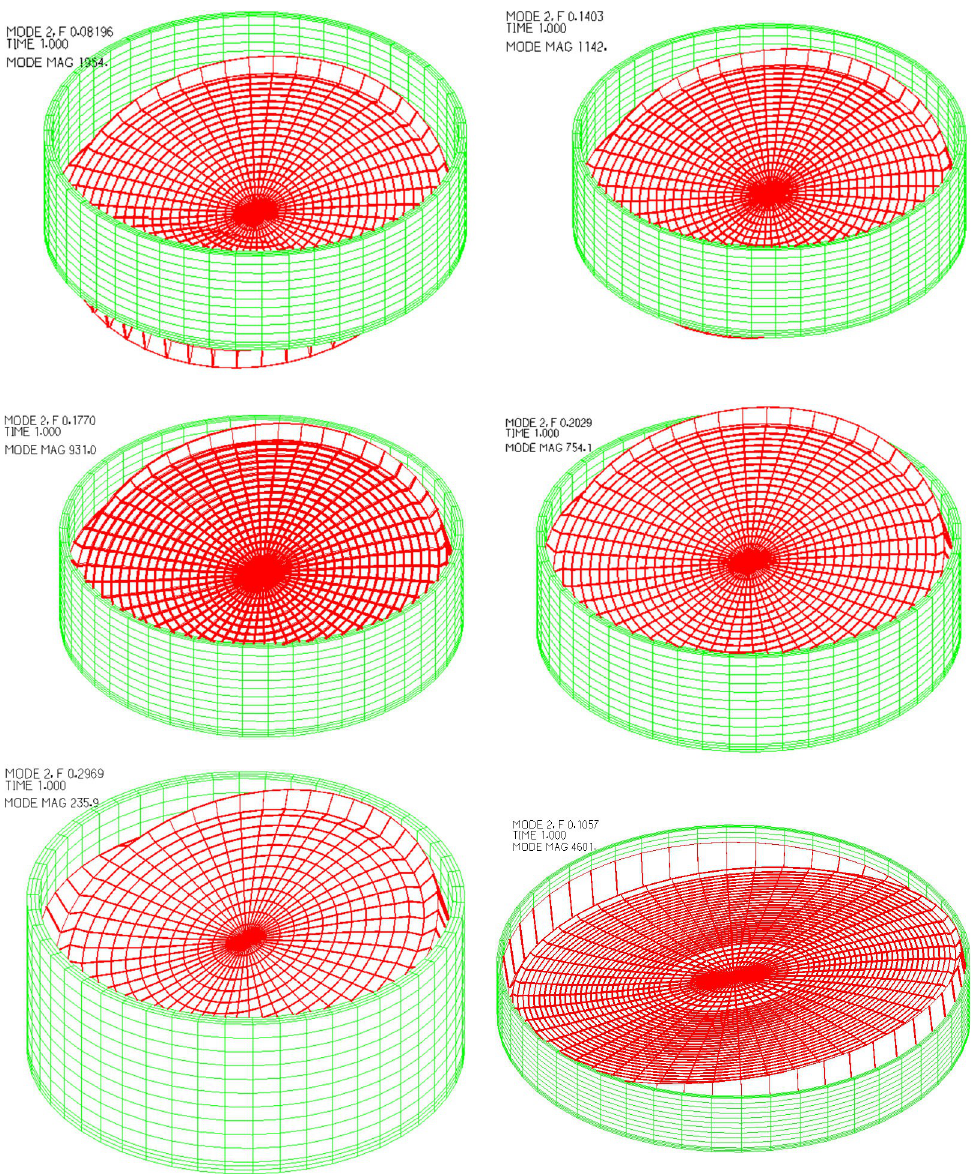
Implicit mode is selected when calculating hydrodynamic pressure. After static calculation in ADINA, the pressure at the corresponding position is extracted as the hydrostatic pressure, and the results are listed in Column 3 of Table 8. For Dynamic-Implicit calculation in ADINA, the pressure at the corresponding position is extracted as the total pressure, the